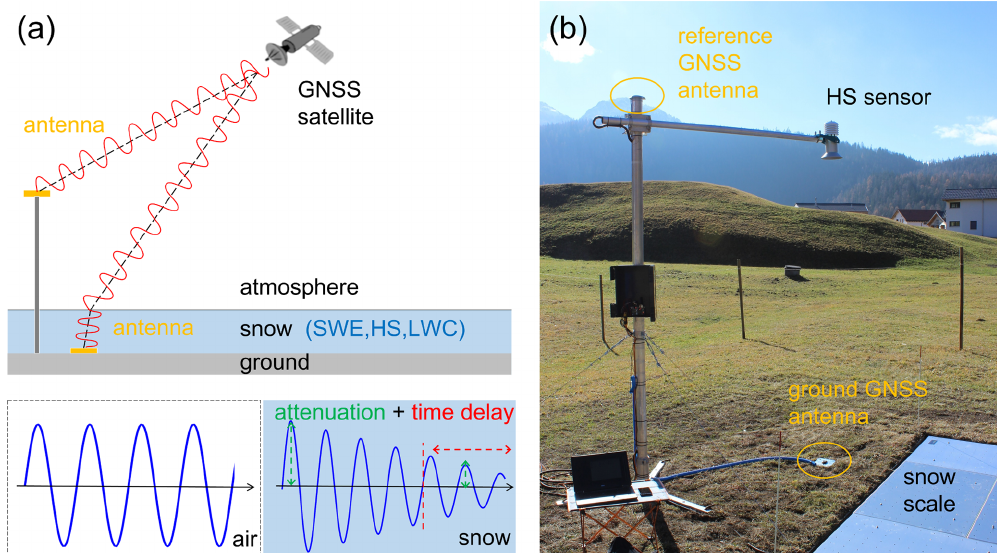
Figure 1. (a) Schematic representing the GNSS sensor setup and the measuring principles. The bottom graphics illustrate the phase delay and attenuation of the GNSS signal in snow. (b) Measuring station at site Laret with GNSS sensor setup as well as automated HS and SWE sensors for validation. The pressure sensor “snow scale” is partially visible in the lower right